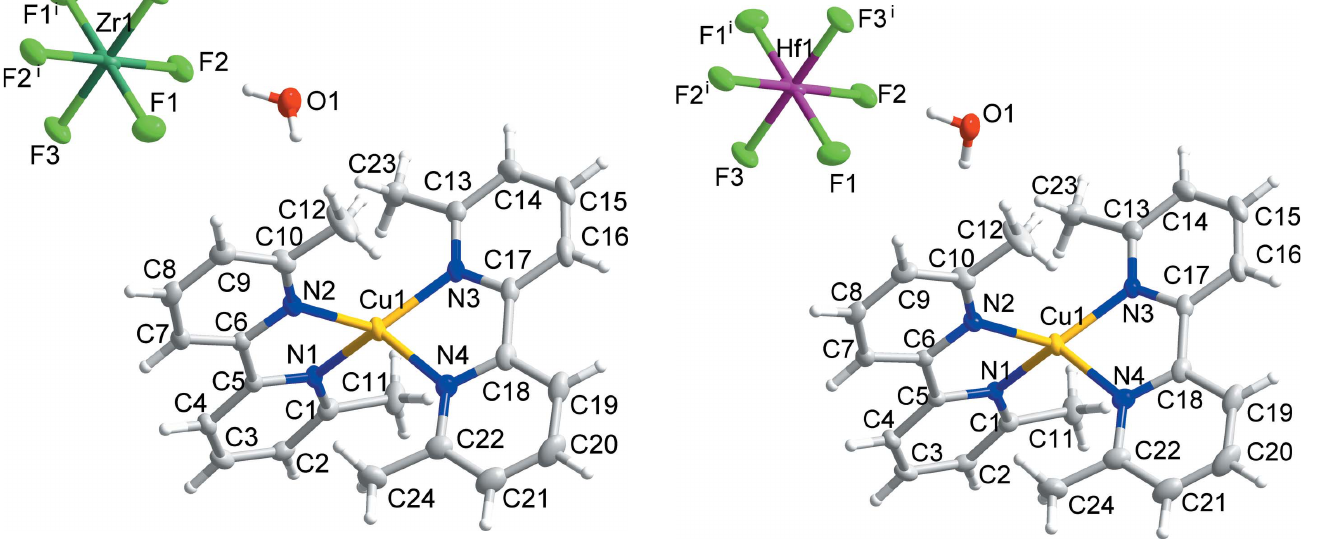
Figure 2 The molecular structure of (II) showing 50% displacement ellipsoids.